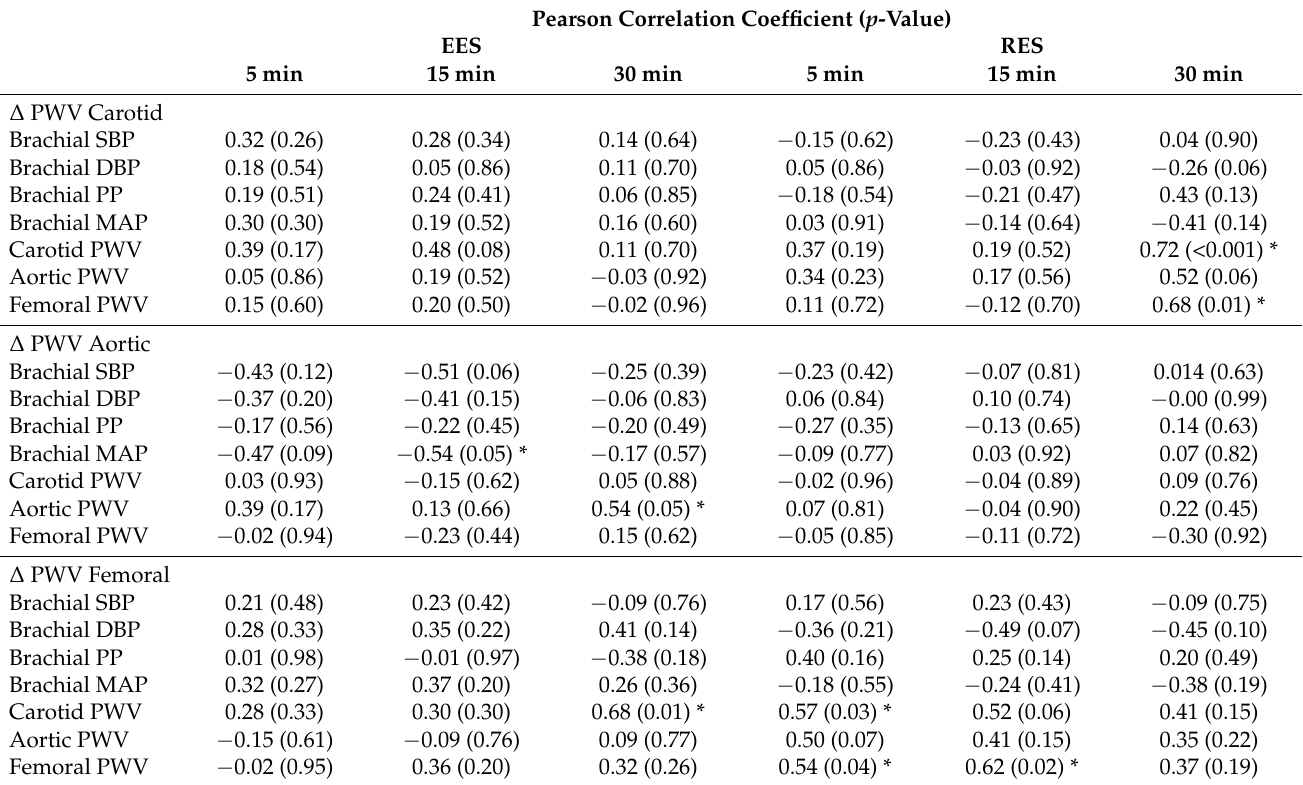
Table 4. Correlation coefficients for central and peripheral PWV